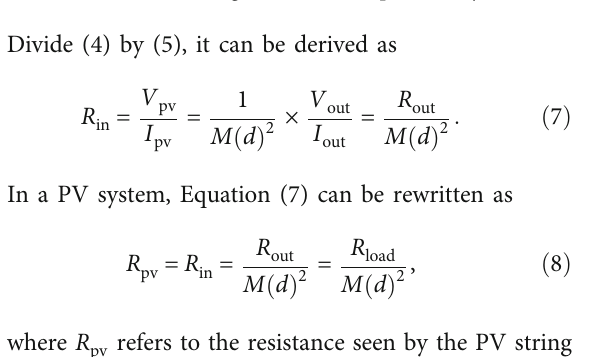
Figure 9: Schematic diagram of the complete PV